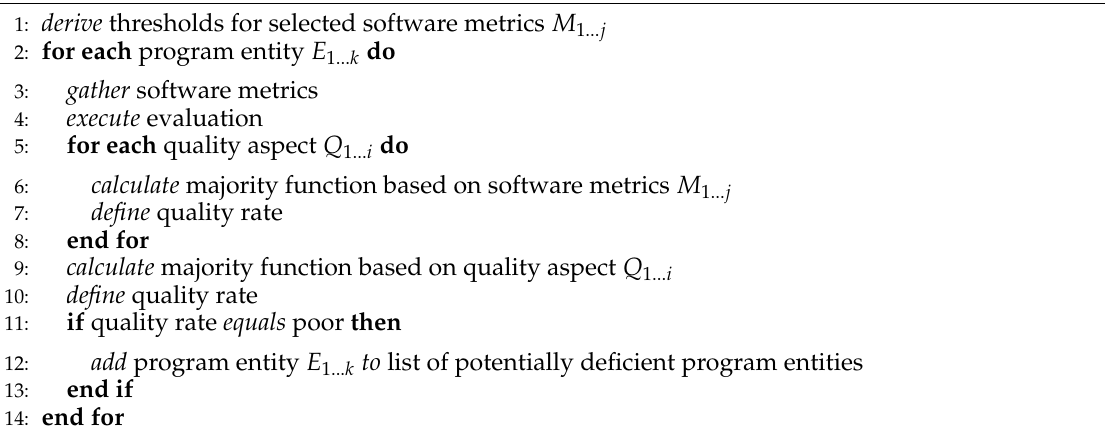
Algorithm 1 Detailed structure of the proposed approach for the identification of deficient program